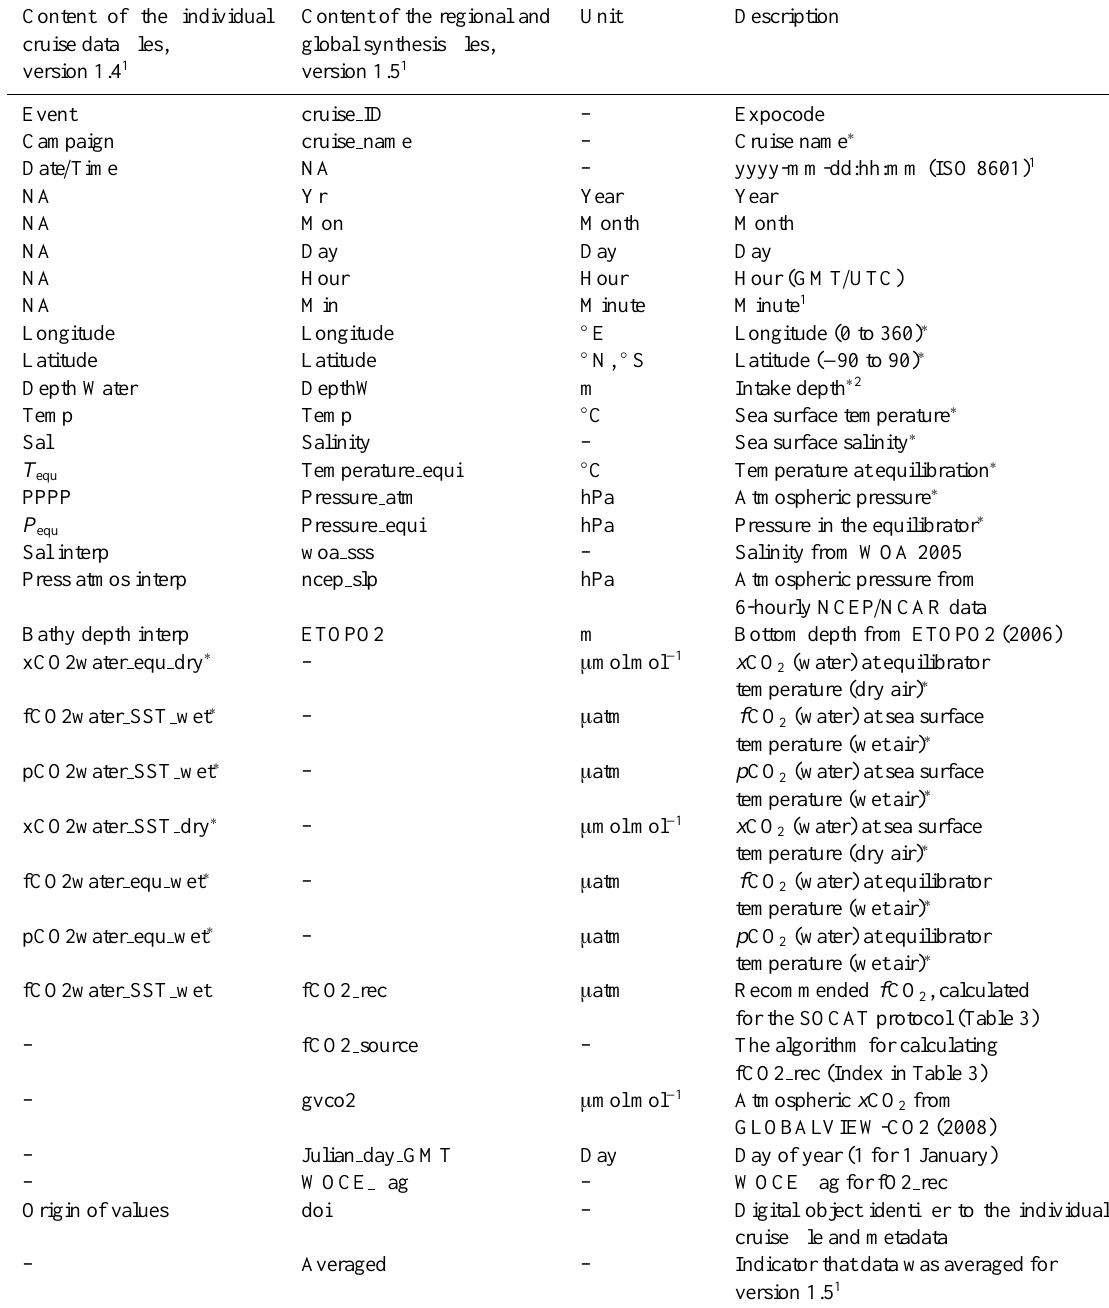
Table 5. Content of the individual data cruise files (version 1.4) and the global and regional concatenated files (version 1.5) in SOCAT 1 (Sects. 5.1, 5.2 and